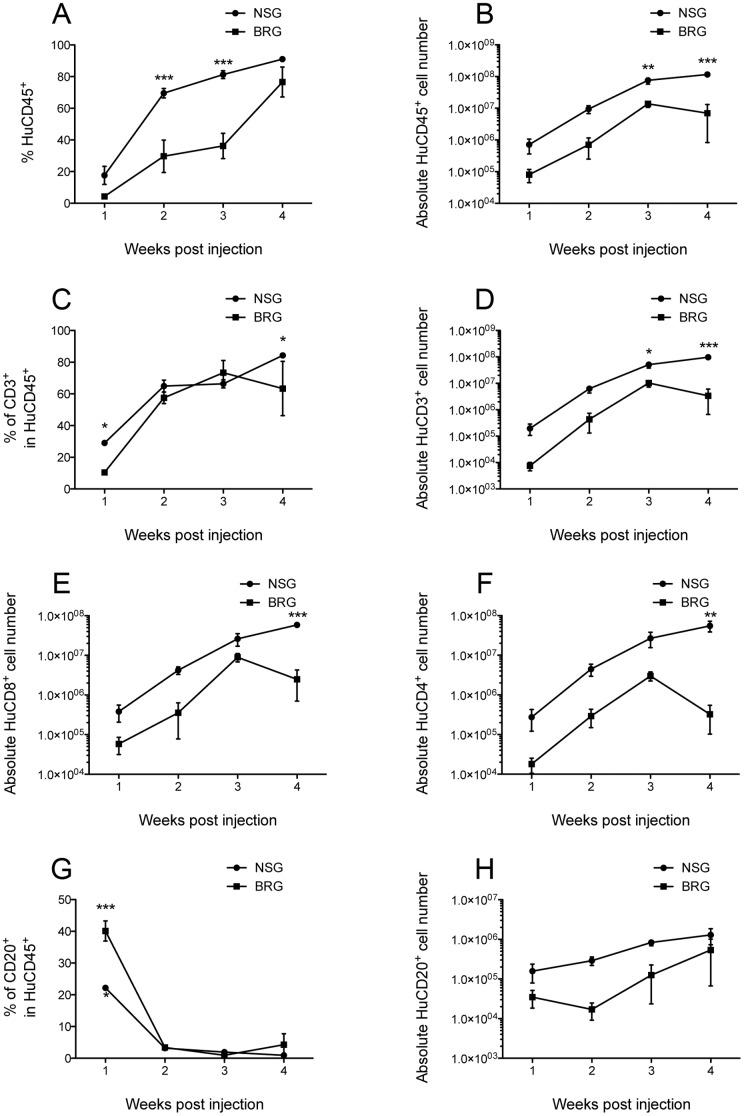
Kinetics of splenic lymphocyte engraftment in Hu-PBMC NSG and BRG mice.Cells were harvested from the spleens of Hu-PBMC NSG and BRG mice at weekly intervals following transfer and stained with anti-human specific antibodies for mouse CD45 and for human CD45, CD3, CD4, and CD20. Samples were analysed by flow cytometry to calculate the % of human (A) CD45+, (C) CD3+ and (G) CD20+, the absolute accumulation of human (B) CD45+, (D) CD3+, (E) CD8+, (F) CD4+ and (H) CD20+ cells. 2-way ANOVA test was performed. Data are compiled from 2 independent experiments (NSG n = 4–5 per time point and BRG n = 4 day 7–21 or n = 2 day 28, 2 PBMC donors).